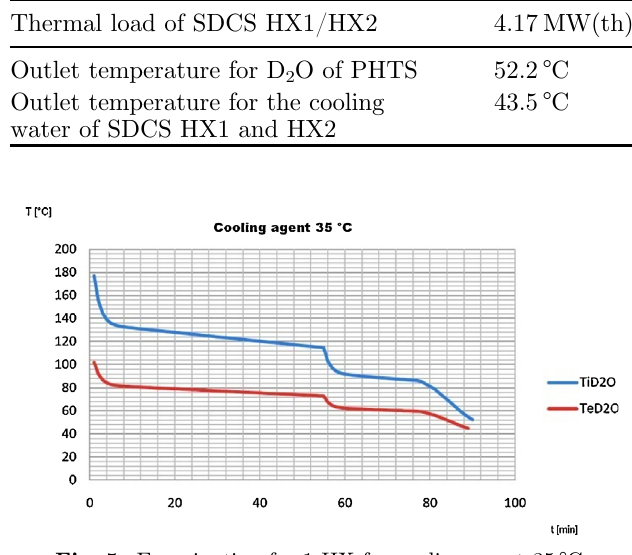
Fig. 5. Examination for 1 HX for cooling agent 35 ° C.